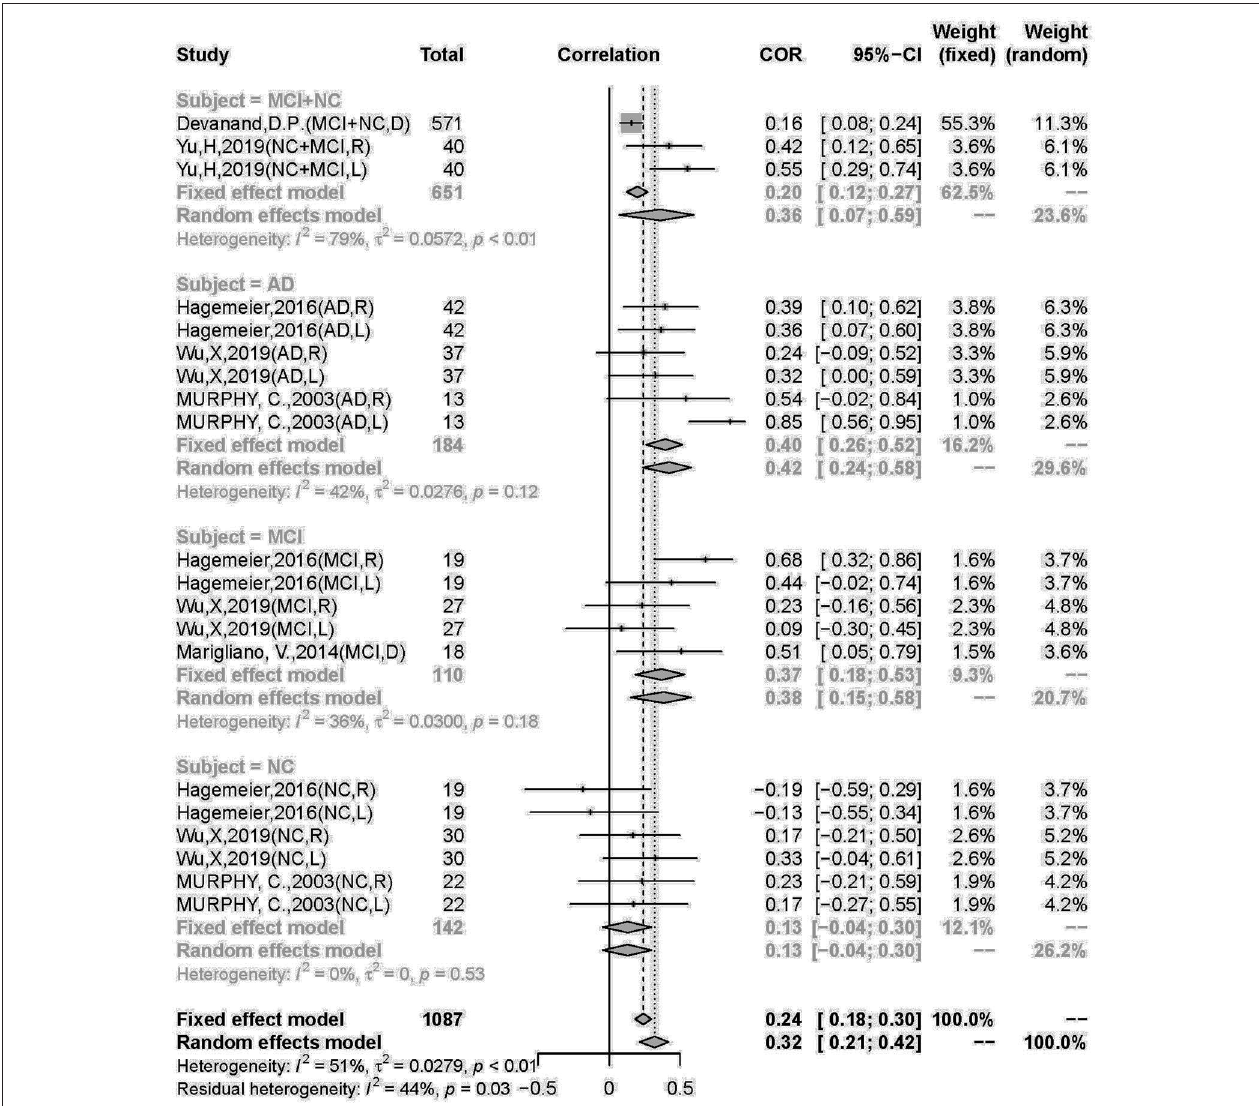
FIGURE 4 | Subgroup analysis in different subject in group of AD, MCI,